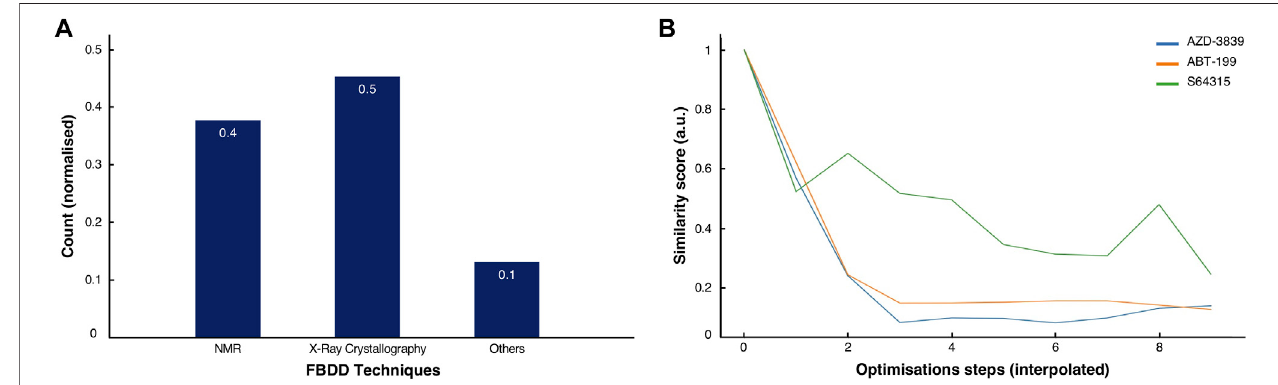
FIGURE5| Comparisonofmethodsandhistoryofclinicaldrugs. (A) Normalisedscoreofthepredominantmethodologiesusedforthediscoveryanddevelopment ofthe 53clinical drugs inspected inthis study. (B) Normalisedsimilarity scores forthe ABT-199 (orange), the S64315 (green) and the AZD-3839 (blue) fragment-to-drug developments pathways with interpolated optimisations